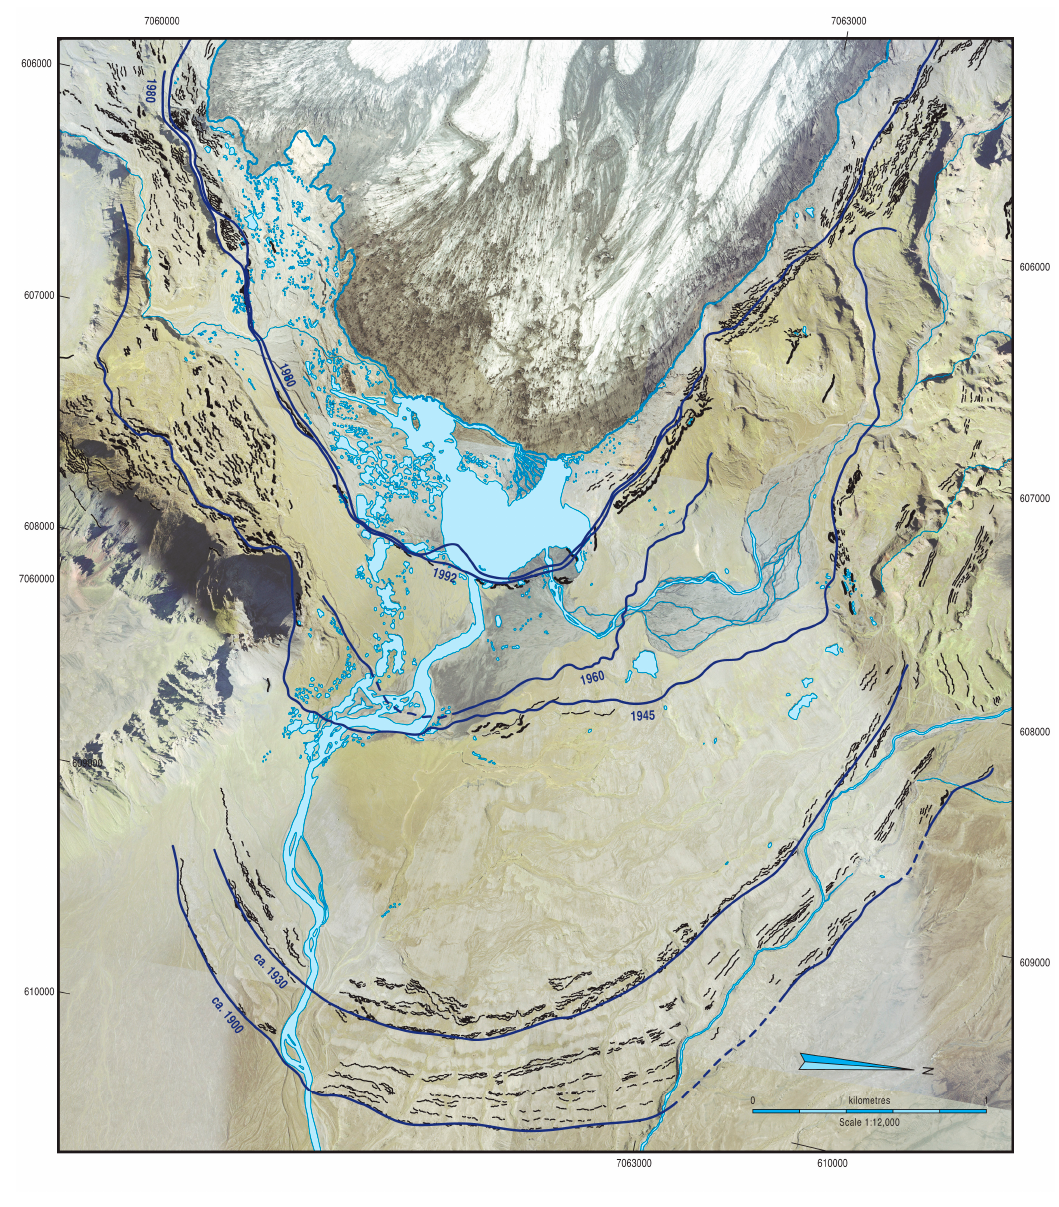
Figure 3. Historical glacier snout margins identified on aerial photograph archives (post 1945) and using lichenometric dating (pre 1945) by Evans et al. [25]. Dated margins are superimposed on the aerial photograph mosaic from 2007 together with the moraine layer from the geomorphological mapping reported in this paper: ( a ) Oldufellsjökull; and, ( b ) Sandfellsjökull.